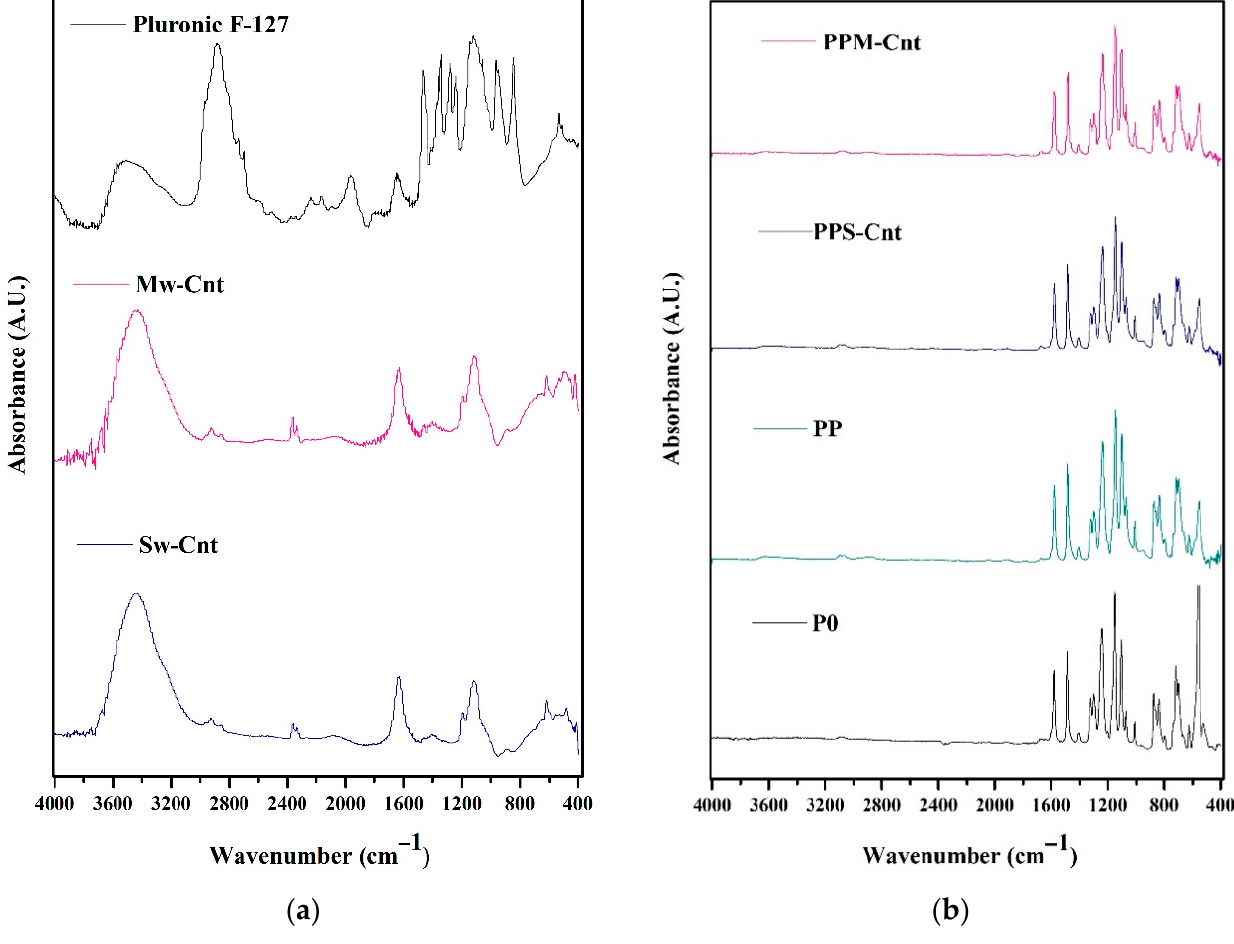
Figure 5. The ATR-FTIR spectra of additives ( a ) and all membranes ( b ) water droplet on top of the membranes’ surfaces.